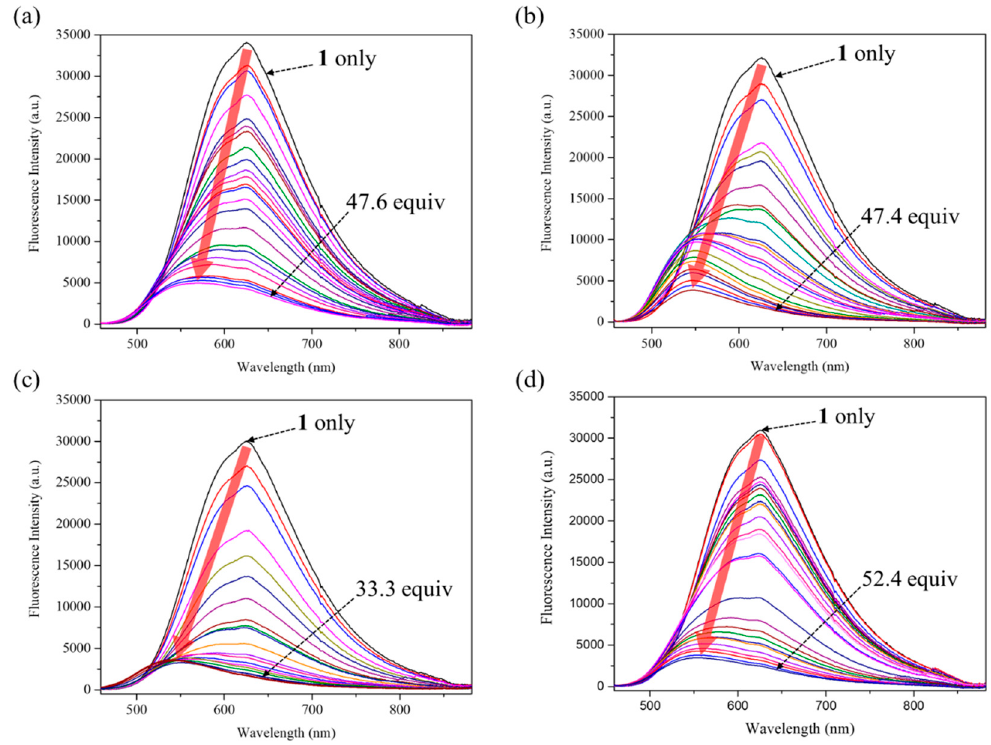
Figure 11. Fluorescence spectral changes of receptor 1 (100 µ M) observed during the titrations with ( a ) TBAF, ( b ) TBAH 2 PO 4 , ( c ) (TBA) 3 HP 2 O 7 , and ( d ) TEAHCO 3 in CH 3 CN. The excitation wavelength ( λ ex ) was 448 nm. The black dotted arrows indicate the fluorescence spectra of receptor 1 in the presence of the indicated anion equivalents. The red T arrows indicate fluorescence spectral changes over the courses of titrations.